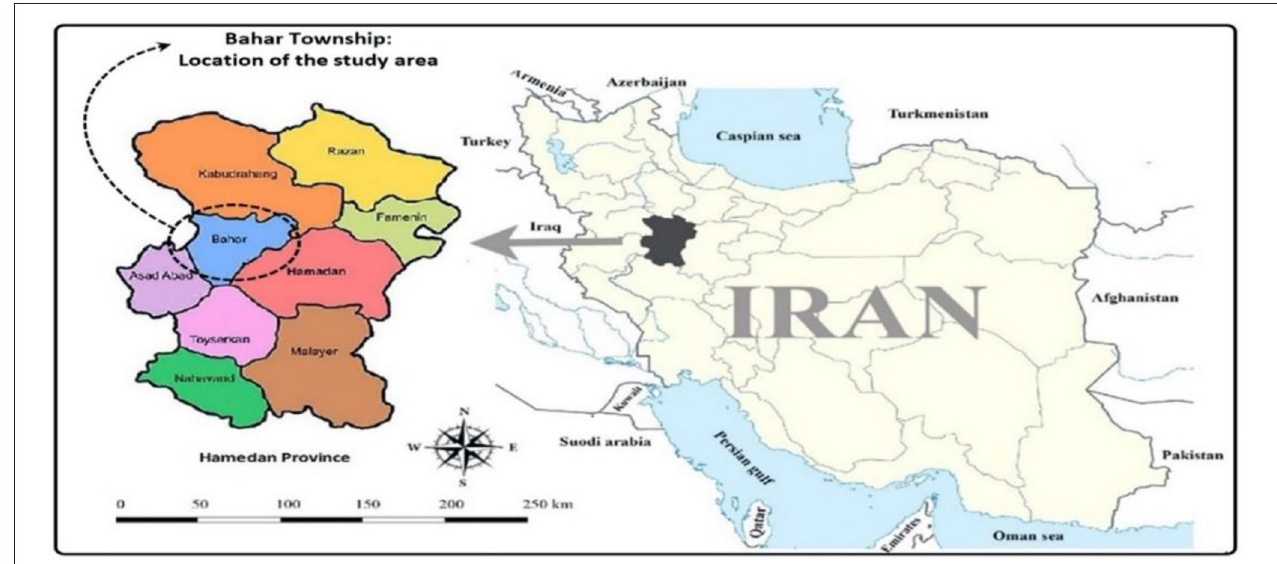
FIGURE 1 | Geographical location of the study